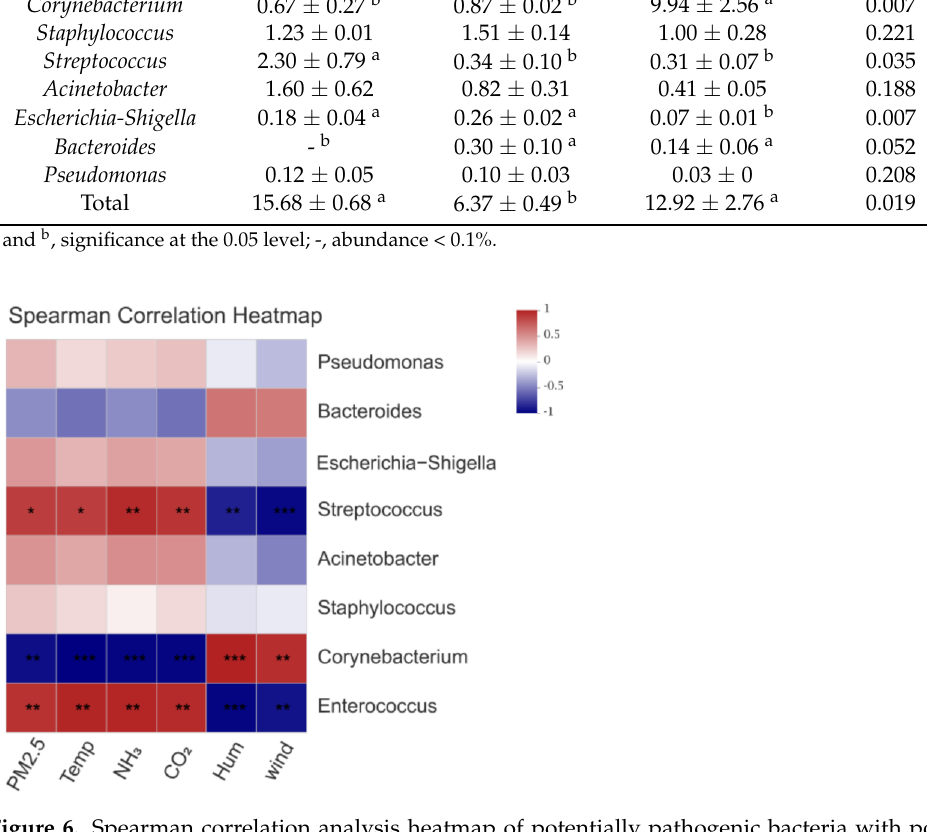
Figure 6. Spearman correlation analysis heatmap of potentially pathogenic bacteria with poten- tial pathogens and environmental control variables. * represents p < 0.05; ** represents p < 0.01; *** represents p <